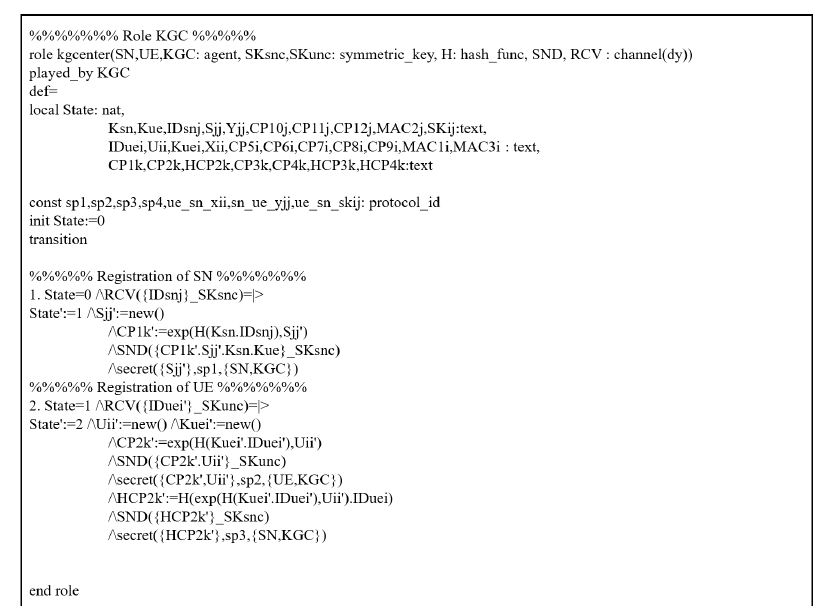
Figure 4. Scenario 1: HLPSL description of UE role.